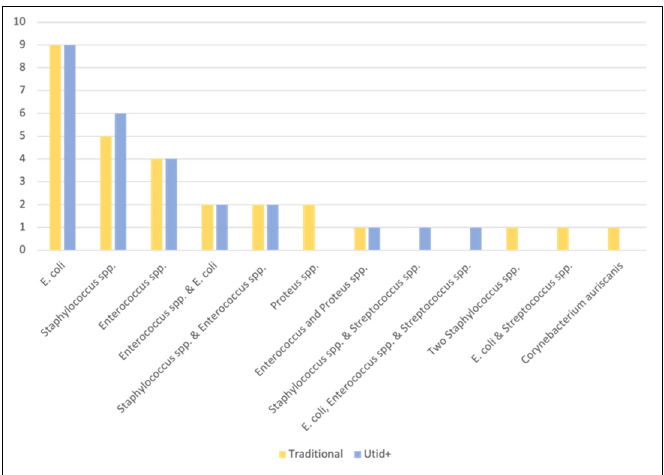
Figure 1. Distribution of bacteria identified from urine specimens by method.